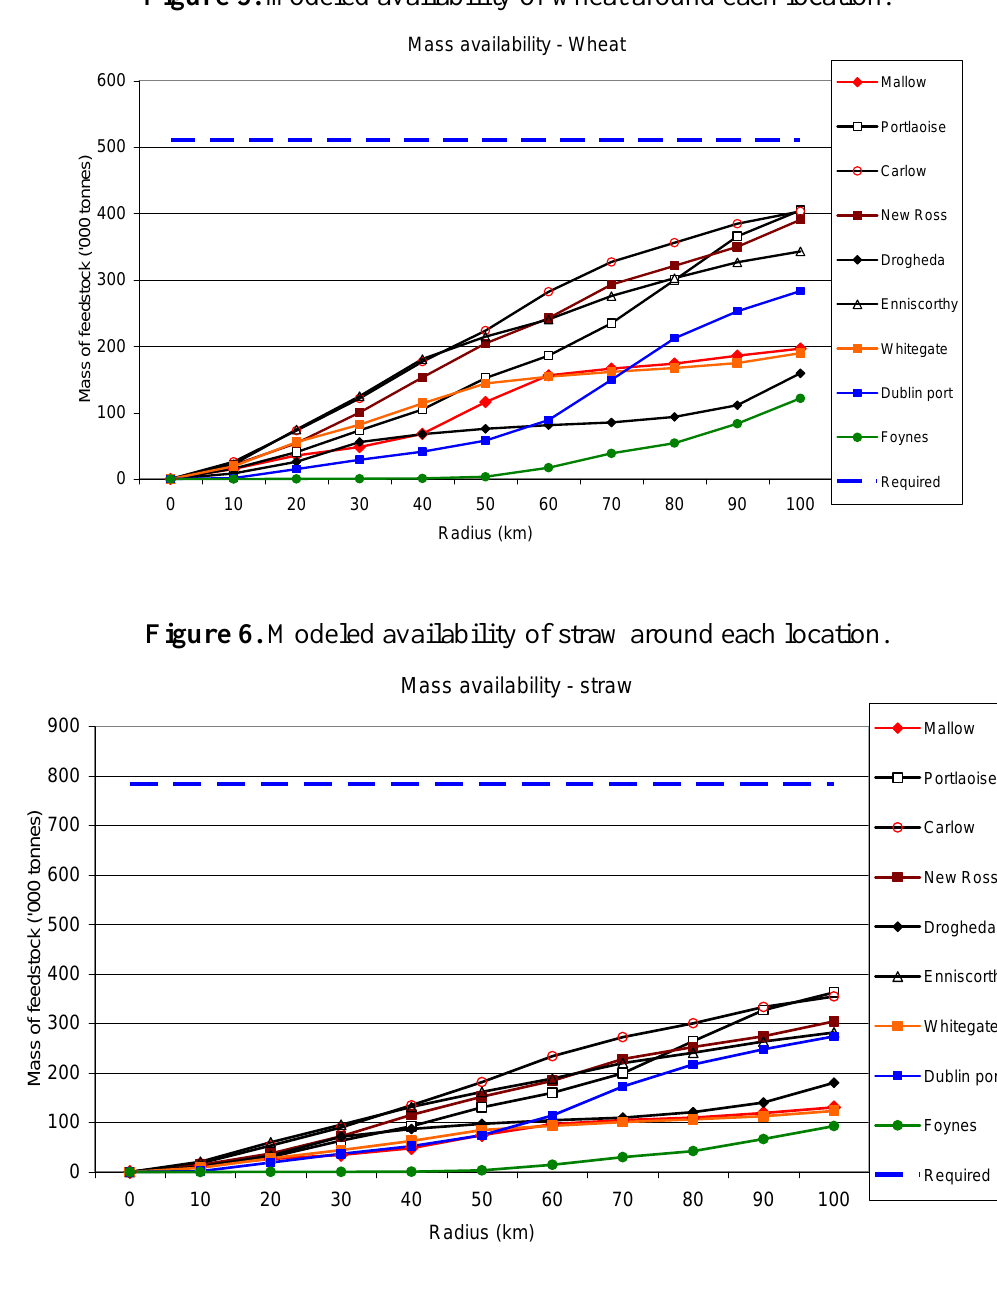
Figure 5. modeled availability of wheat around each location.